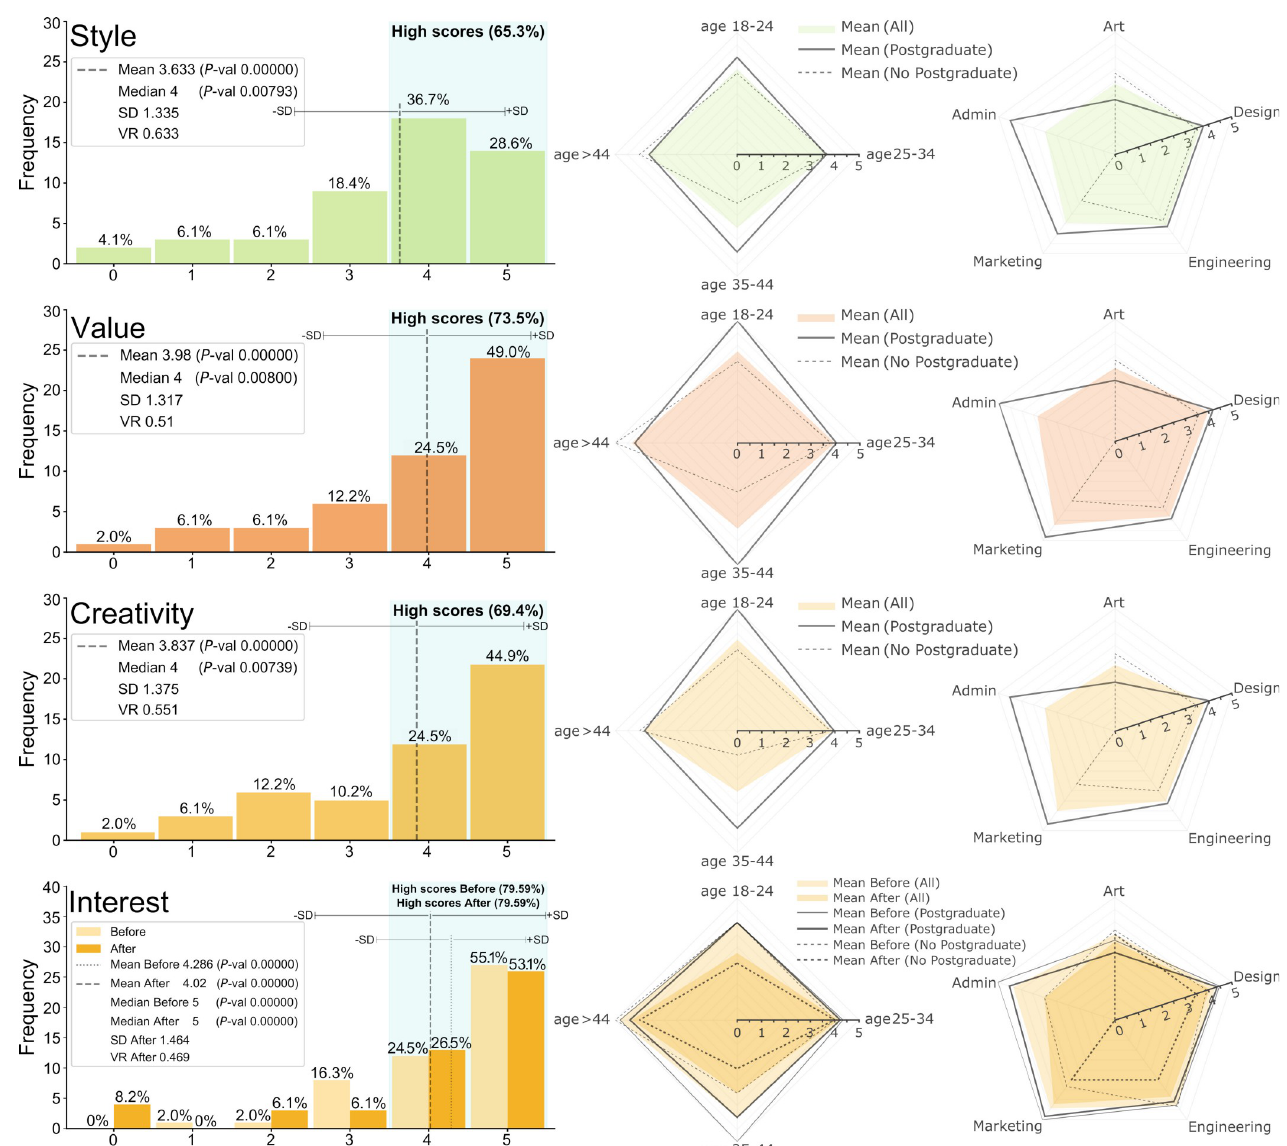
Fig 21. Survey results of perceptions about Shapi’s capabilities and potential value with 0–5 scores. Results are displayed by frequency, age group, occupation, and Postgraduate studies.